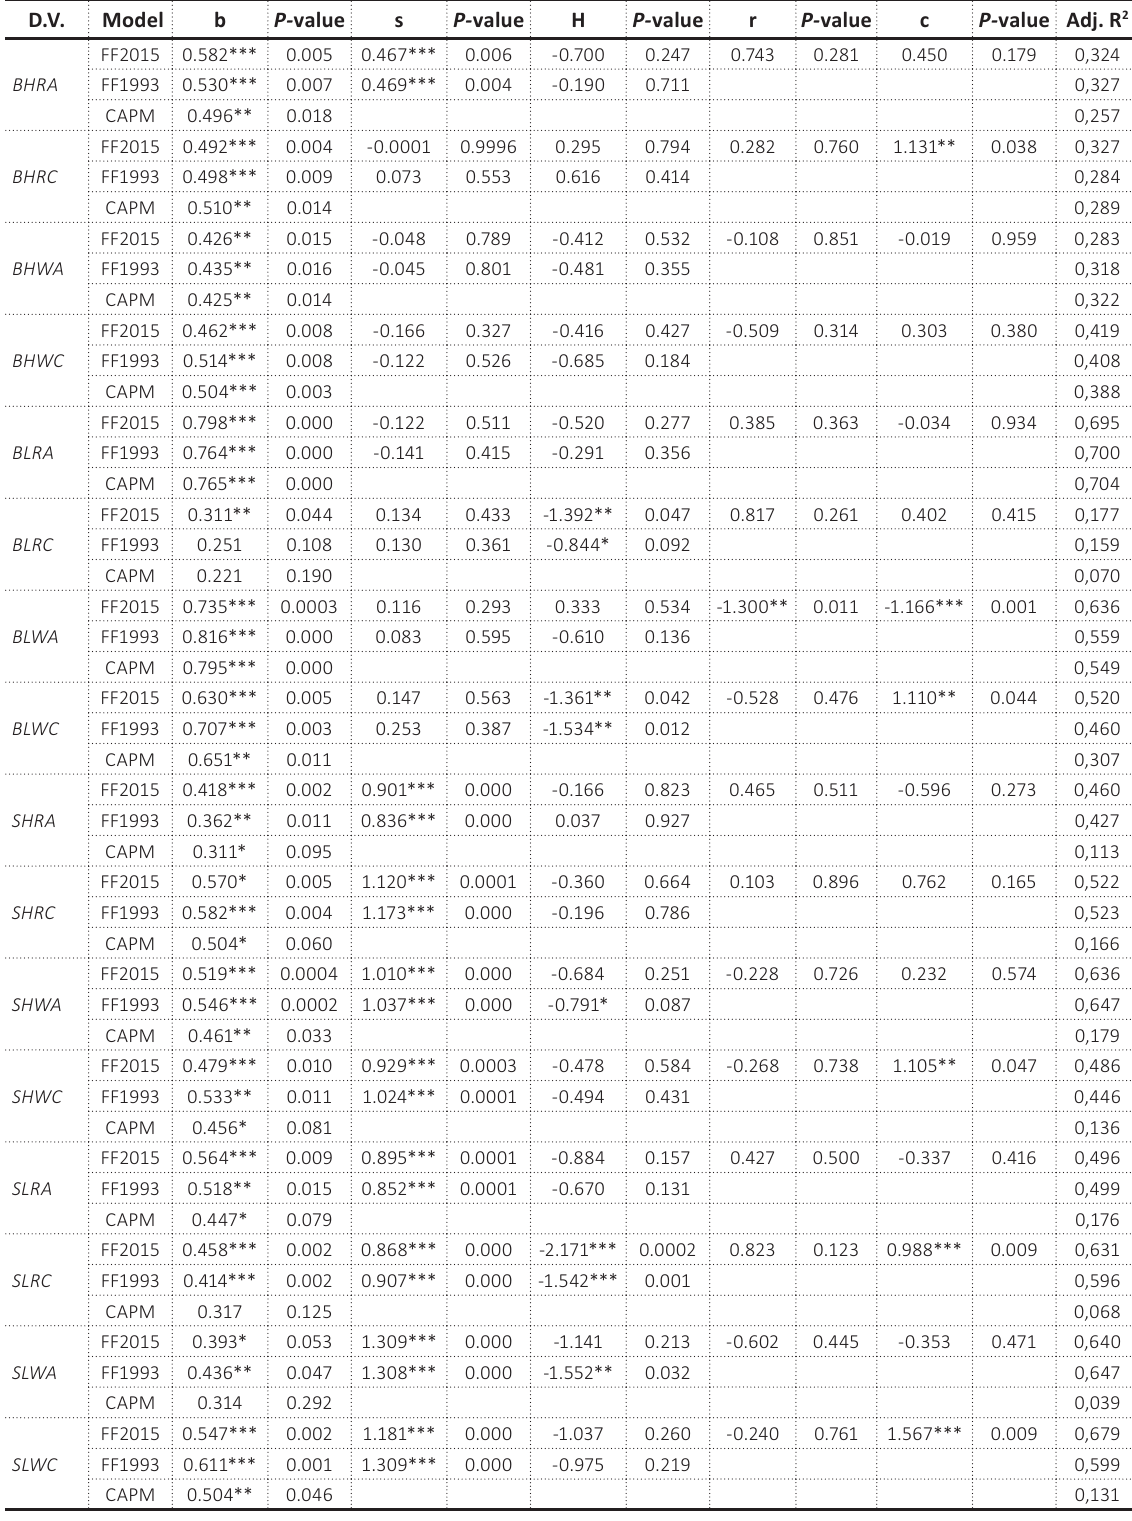
Table H1. Coefficients: 2x2x2x2 factors sort on Size, B/M, OP,